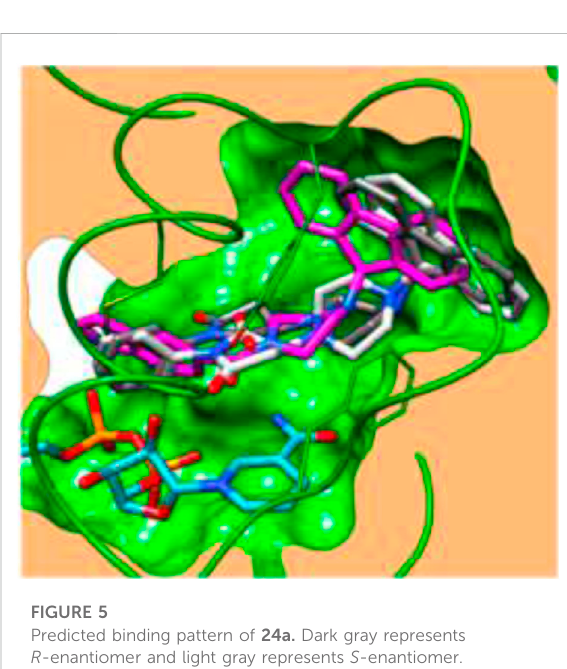
FIGURE 5 Predicted binding pattern of 24a. Dark gray represents R -enantiomer and light gray represents S -enantiomer. Reproduced from Matviiuk et al., 2014a, with permission from Elsevier, Copyright